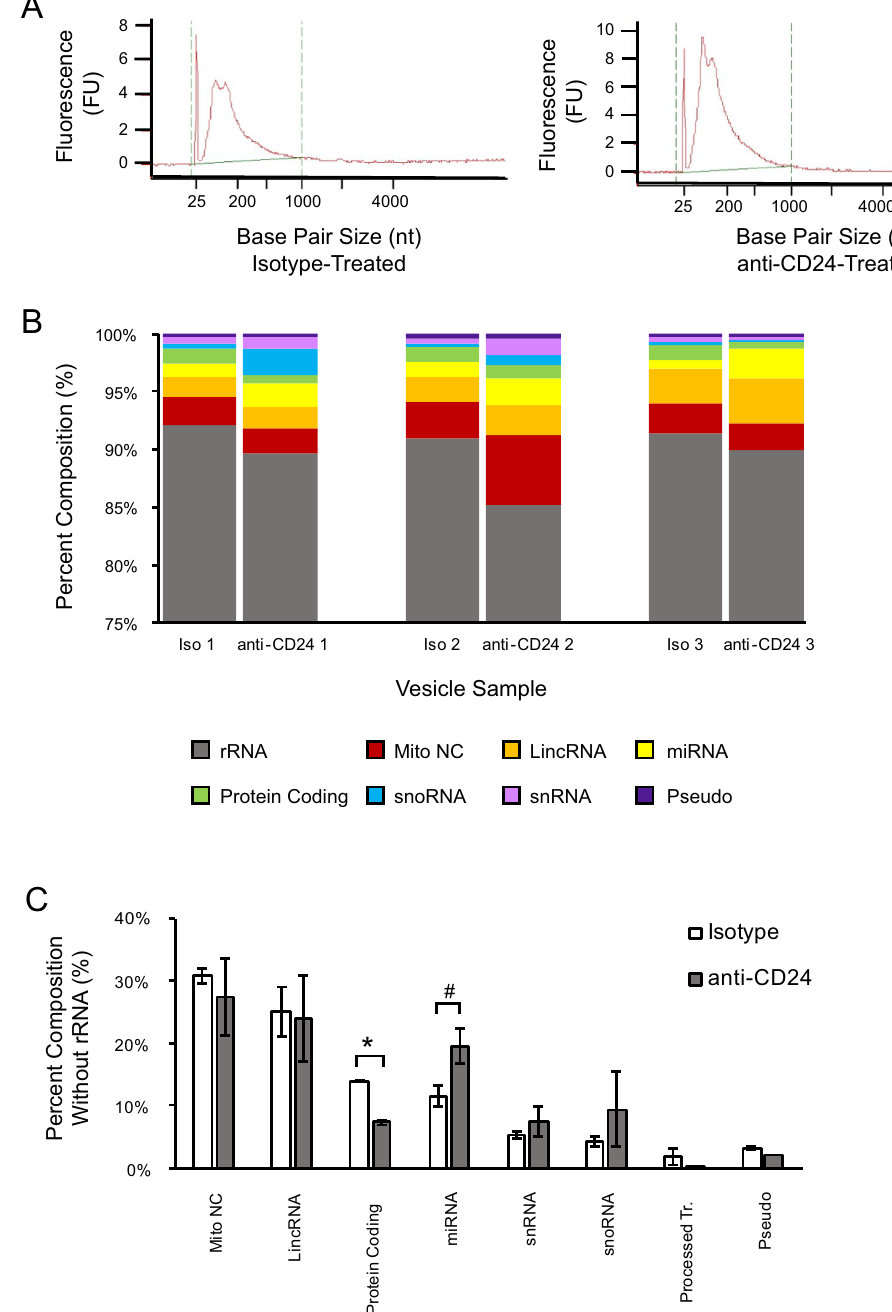
Figure 2. CD24 stimulation alters the abundance of protein coding transcripts loaded into B cell MVs. ( A ) Representative RNA size distributions of MVs collected from cells stimulated with either isotype (right) or anti-CD24 (left) Ab after 1 h. ( B ) The RNA incorporated into MVs from cells after 1 h of either isotype or anti-CD24 Ab stimulations categorized into one of 8 sub-categories containing > 0.2% of the total RNA, n = 3 biological replicates. ( C ) The mean ± SEM percentage of the 8 major non-rRNA transcripts with greater than 2% of RNA abundance from MVs isolated from either isotype (white bars) or anti-CD24 (grey bars) stimulated cells. n = 3, statistics were assessed using a two-tailed Student’s t-test, # p = 0.07; * p <